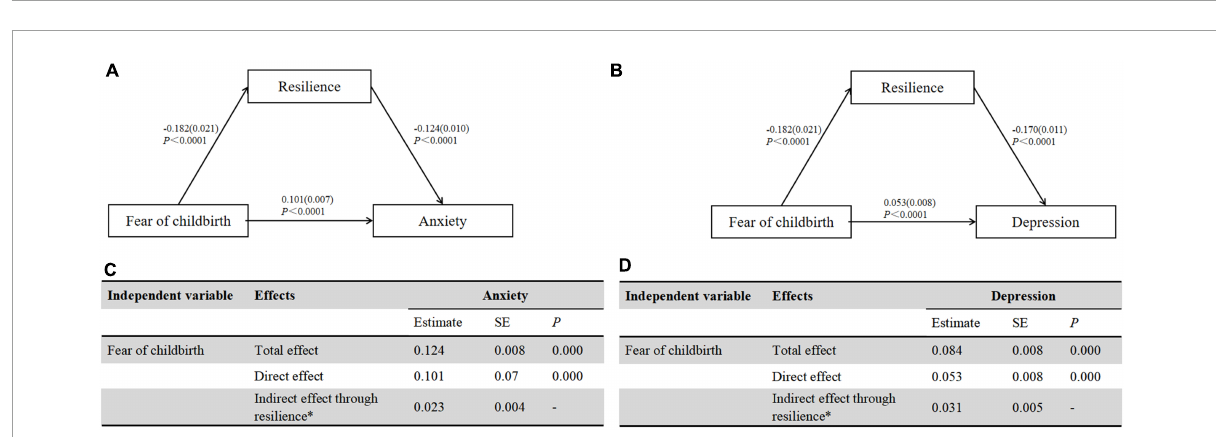
FIGURE3 (A) The mediating effect of resilience on anxiety. (B) Direct and indirect (mediation) effect of resilience on anxiety. (C) The mediating effect of resilience on depression. (D) Direct and indirect (mediation) effect of resilience on